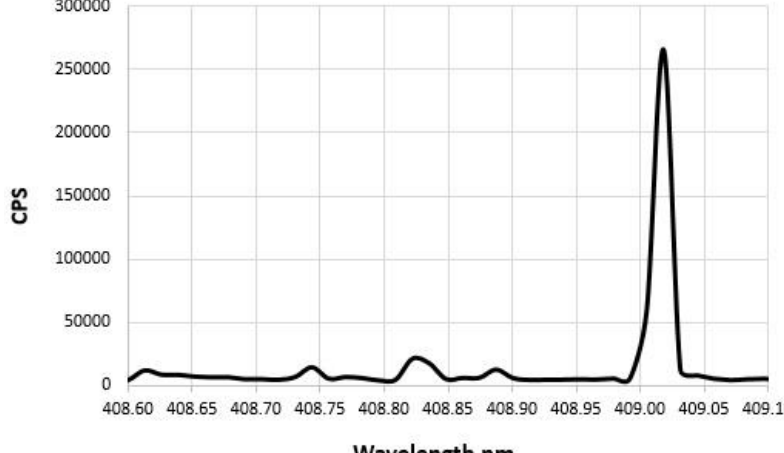
Fig. 4. Measurement spectrum of uranium with ICP-OES technique at 409 nm